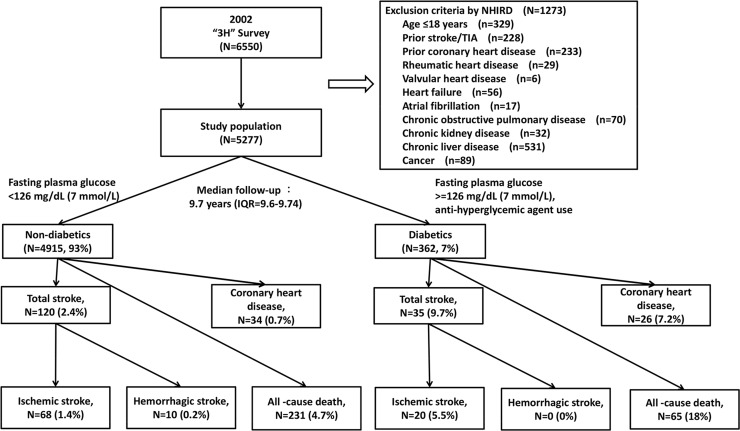
Study flow chart.